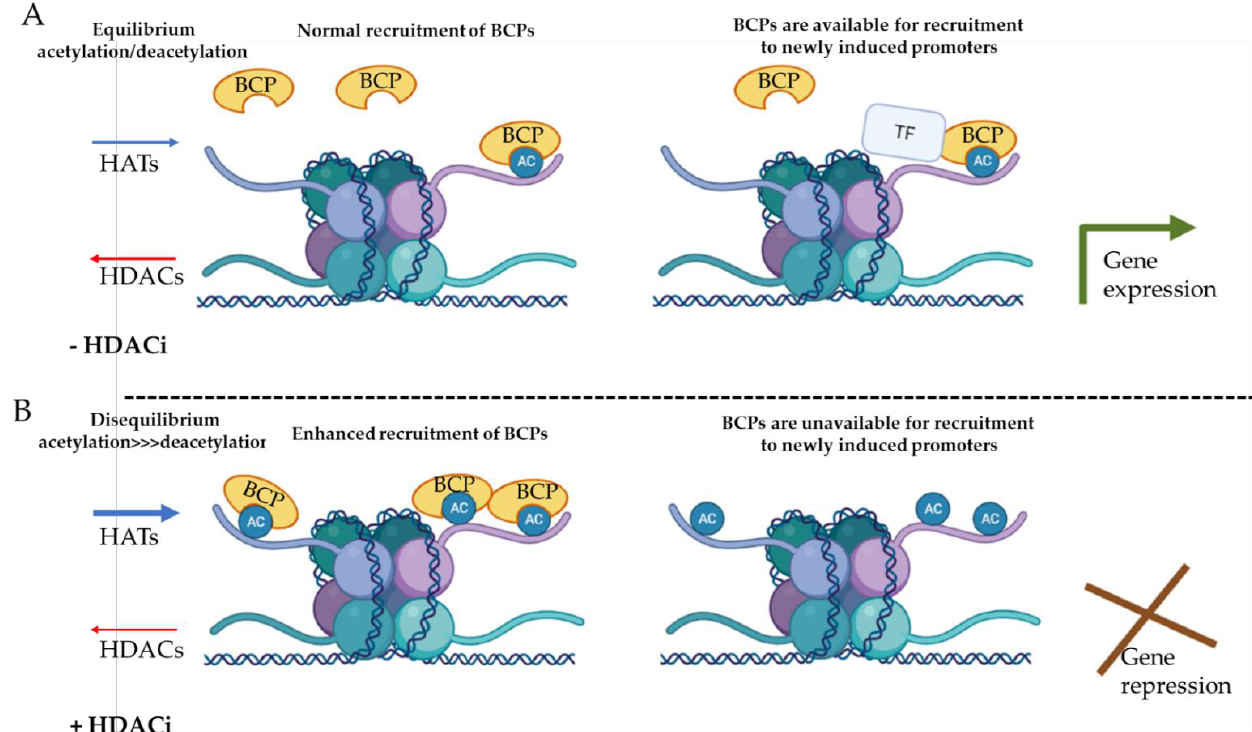
Figure 2. Possible mechanism for inhibition of inflammatory gene expression by HDACi. ( A ) In steady state, there is an equilibrium between acetylation (AC) and deacetylation, which maintains a pool of epigenetic readers available for recruitment to newly induced promoters, recruitment of transcription factors (TF), and induction of gene expression. ( B ) Histone deacetylase (HDACs) inhibition increases acetylation of histones that sequester the epigenetic readers, such the bromodomain-containing proteins (BCPs), preventing their recruitment to newly induced promoters.